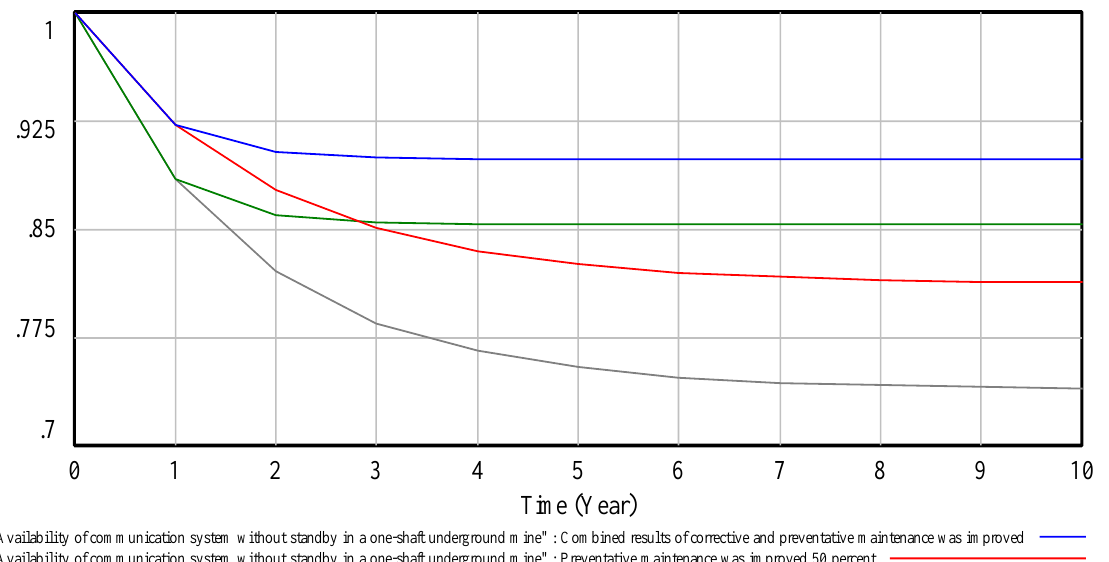
Figure 11. Simulation results of the without standby communication system in one shaft underground mine.